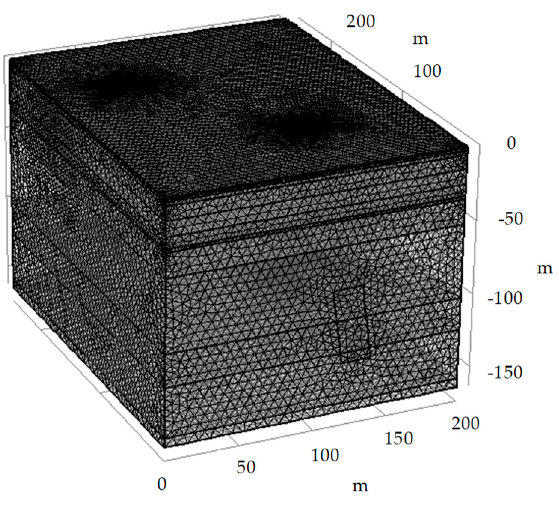
Figure 6. Mesh used to analyze the case of a single fault.